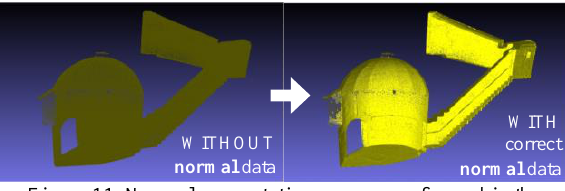
point cloud Figure 10 allows to deliver low-weighted 3D models (Figure 13 top images) between 3Mb (*.obj format) + 9 Mb texture file, instead of (bottom images) a 34Mb model + 10Mb texture. The numbers of triangles in Figure 13 are 1:10 ration between the two different models, but with results almost comparable for the final appearance of the model with the textured mesh (right).